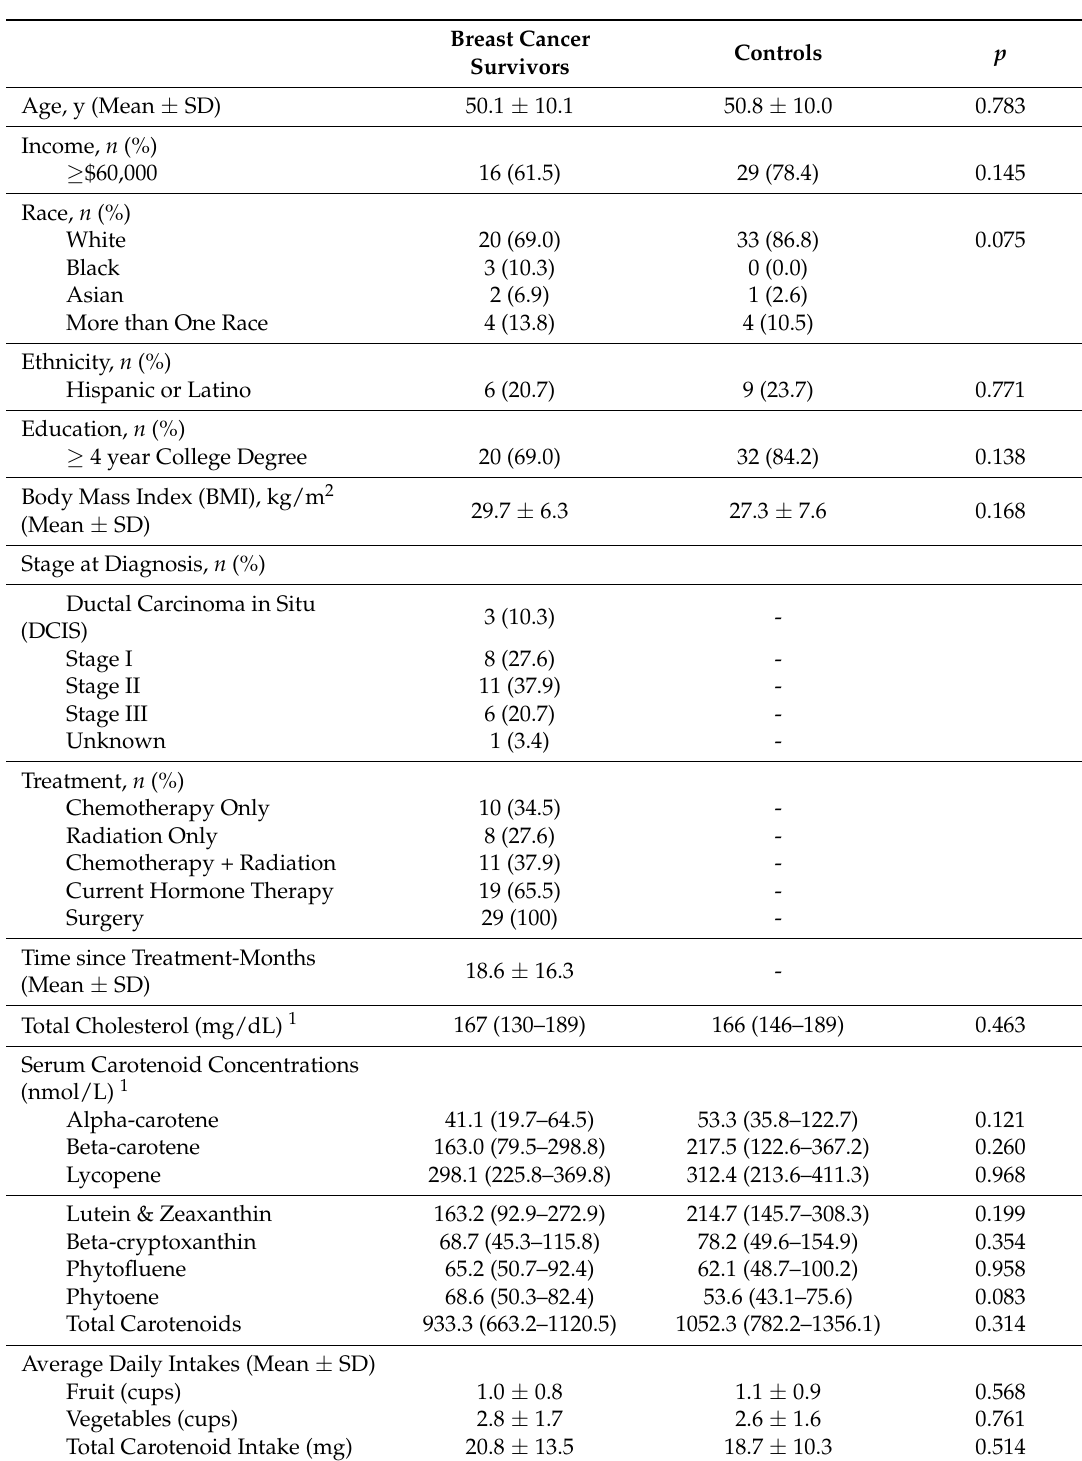
Table 1. Participant